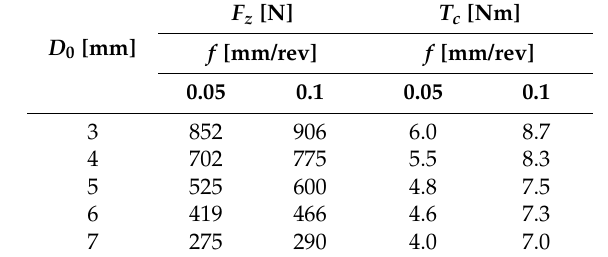
Table 6. Experimental results for F z [N] and T c [Nm] in ingot MoCuSi alloy.